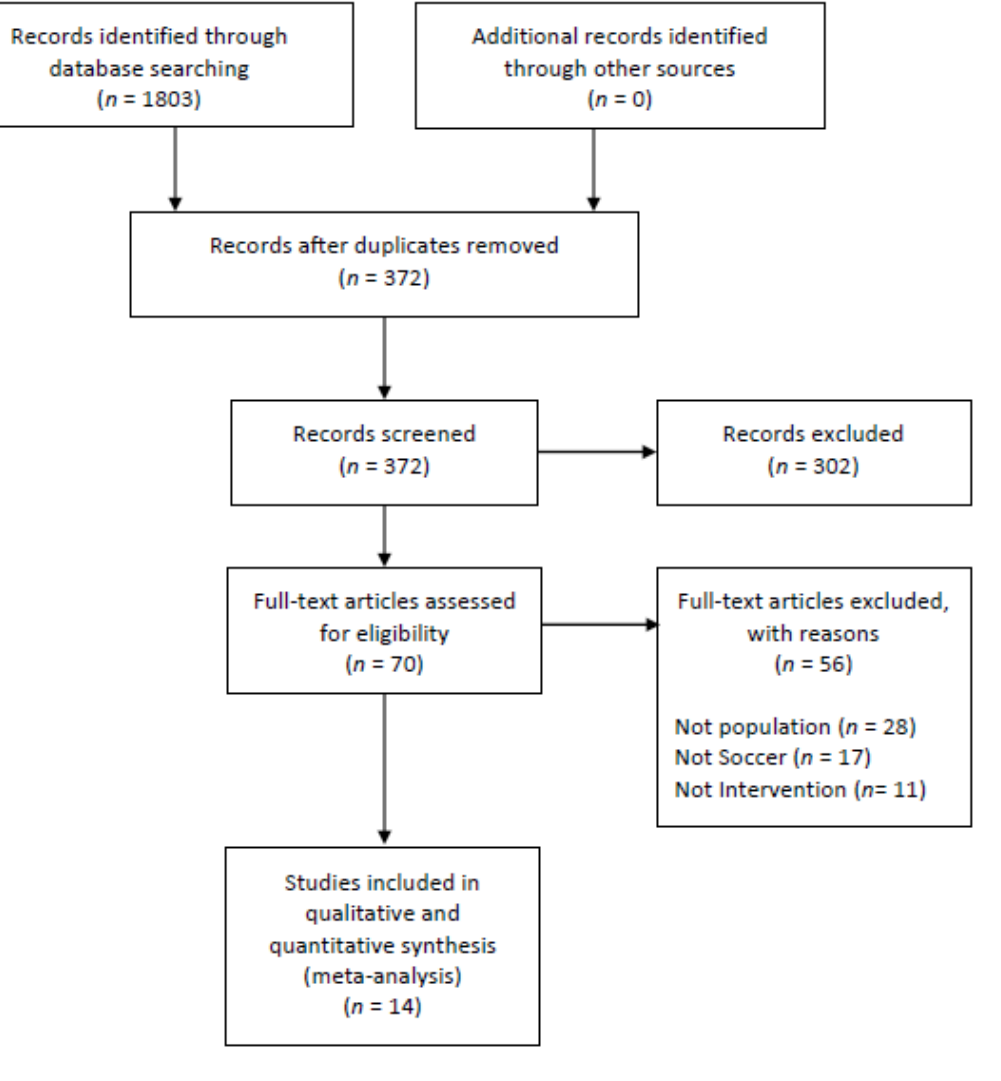
Figure 1. Flow diagram of the selected studies.